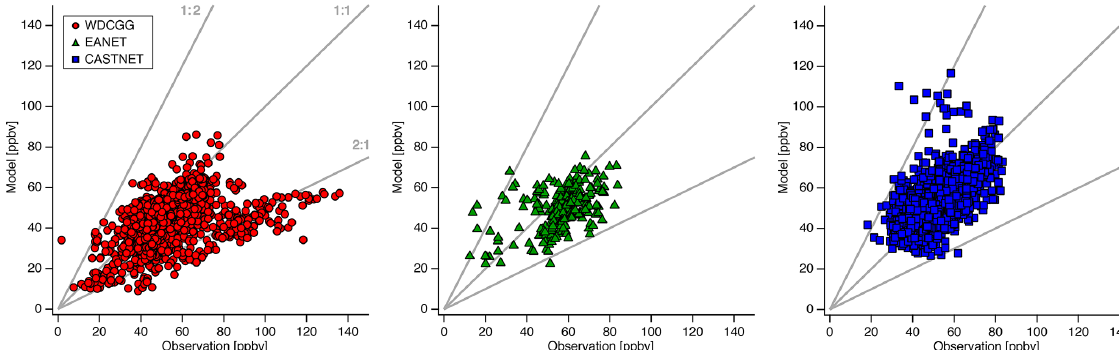
Figure 2. Scatter plot between observations and H-CMAQ simulations for surface MD8O3 during April 2010. Reference lines are provided at ratios of 2 : 1, 1 : 1, and 1 : 2. The symbols and colors used to represent the different surface observational datasets are consistent with Fig.